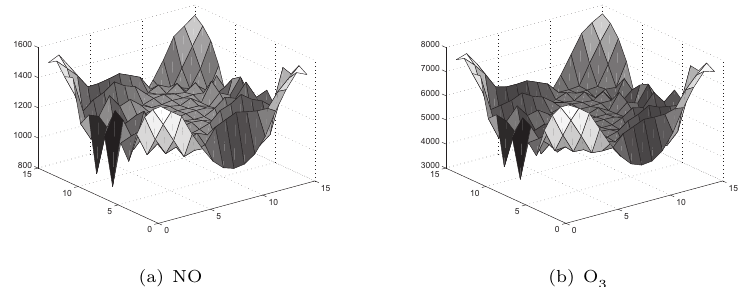
Figure 3. Some pollutants at the end of the time